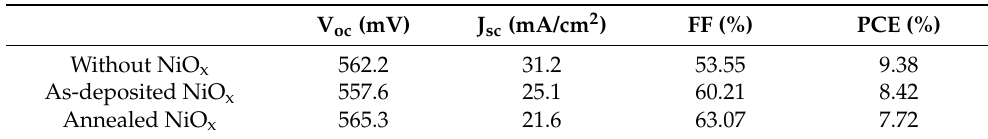
Table 1. Comparison of the performance of a TOPCon solar cell with and without NiOx thin film and with and without